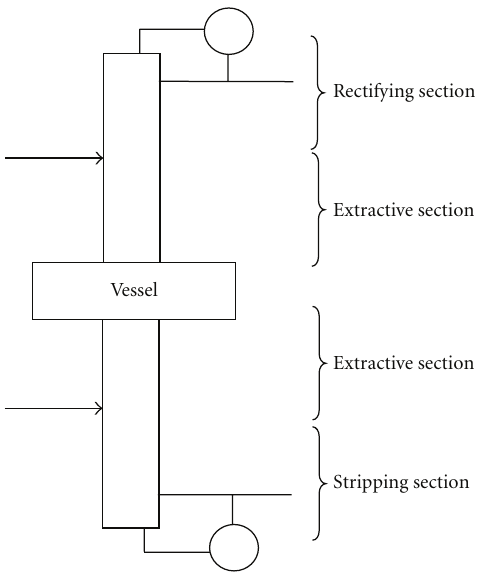
Figure 1: Middle vessel